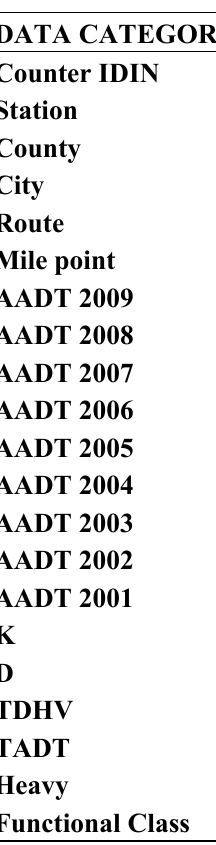
Table 1. Traffic volume